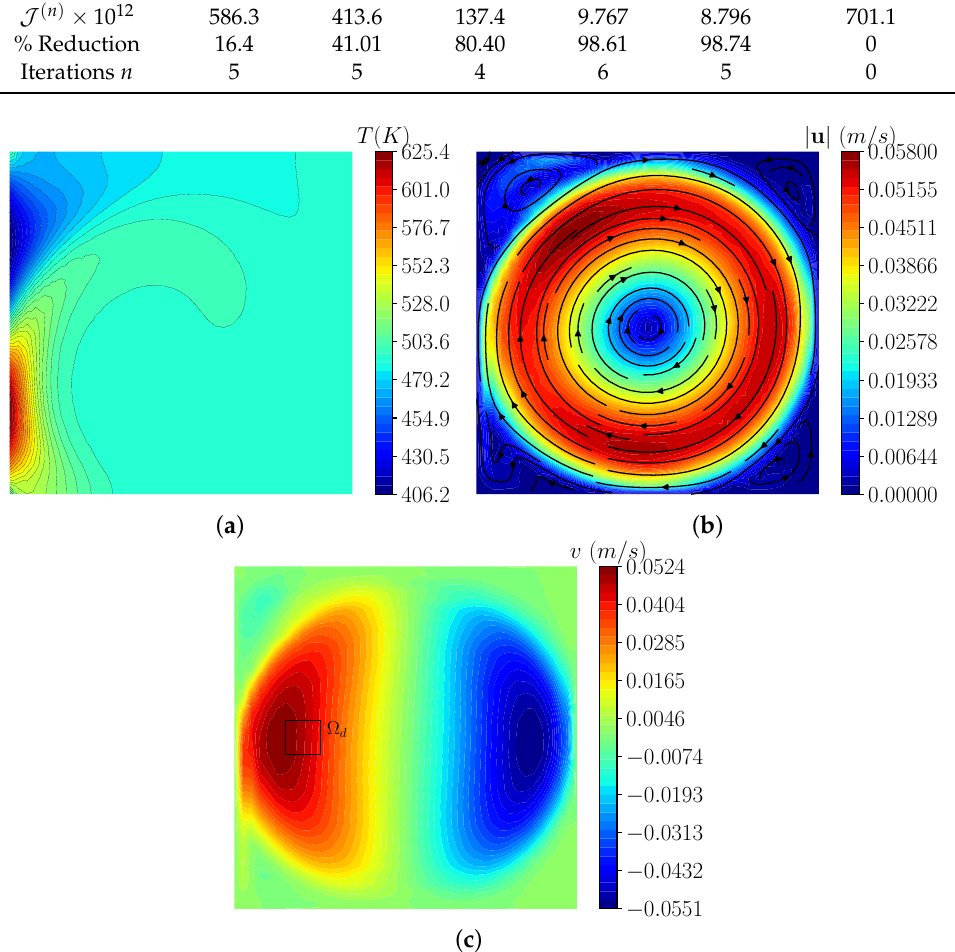
Figure 5. Velocity matching case with Dirichlet boundary control—Case 1: optimal solution for λ = 10 − 13 . Contours of the temperature field T ( a ); contours and streamlines of the velocity field u ( b ); contours of the y -component of the velocity field v ( c ). The velocity magnitude is indicated by u , and Ω d is the region where the objective is | |